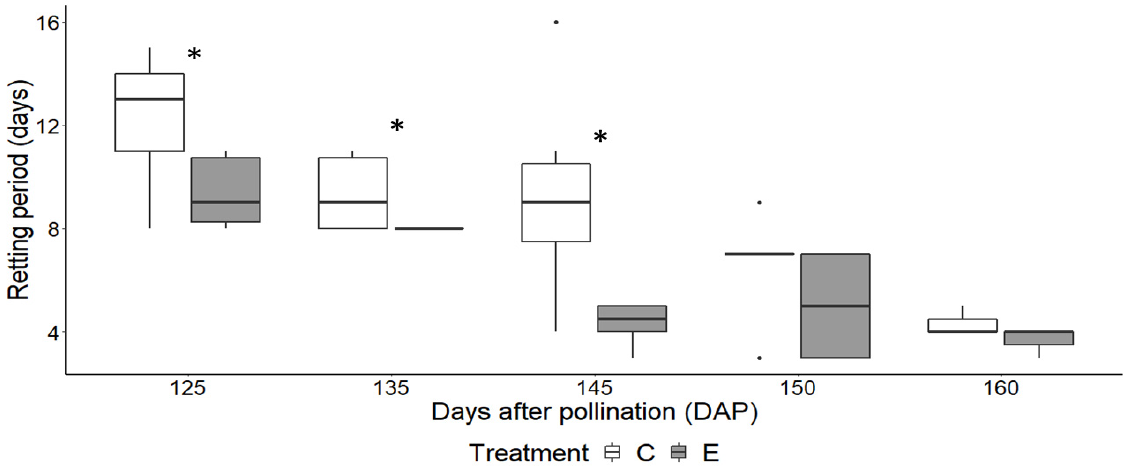
Figure 4. The boxplots represent median values, 25th–75th percentile of retting period (days) between ethephon-treated (E) and control (C) FFB across FFB ripeness. Significant difference in retting period between E and C are denoted by asterisk (*) based on the Kruskal–Wallis test at the p = 0.05 threshold. Eight FFB harvested at 135 DAP were retted at 8 days. Seven FFB harvested at 150 DAP completed retting process at 7 days, with 2 outliers retted at 3 days and 9 days.